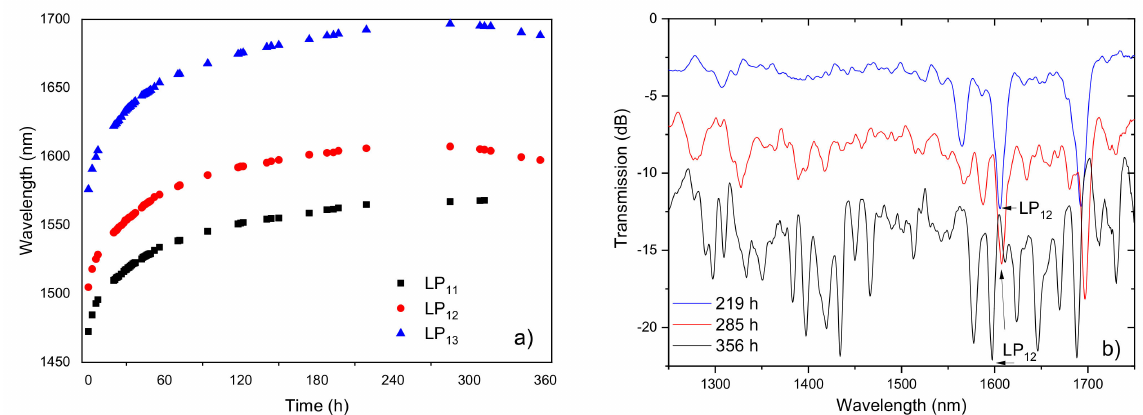
Figure 11. ( a ) Time dependence of the resonance wavelengths of three cladding modes and ( b ) evolution of the grating spectrum during the heat treatment at 1000 ◦ C for two weeks. Adapted with permission from ref. [99]. © 2021